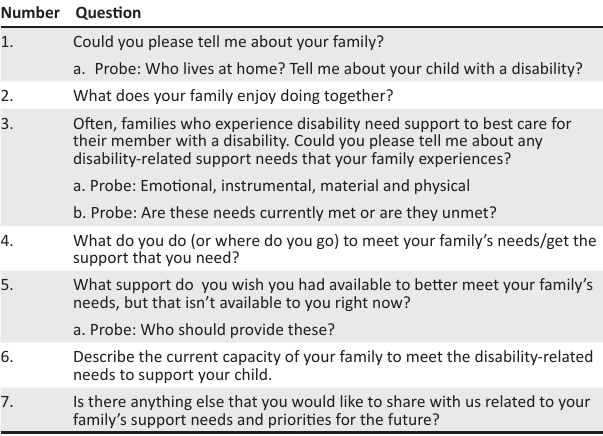
TABLE 1: Interview